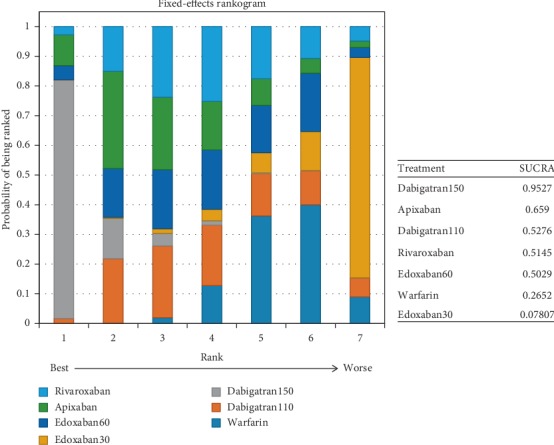
Ranking plots for the efficacy of the comparison among different treatments of patients with moderate renal function.